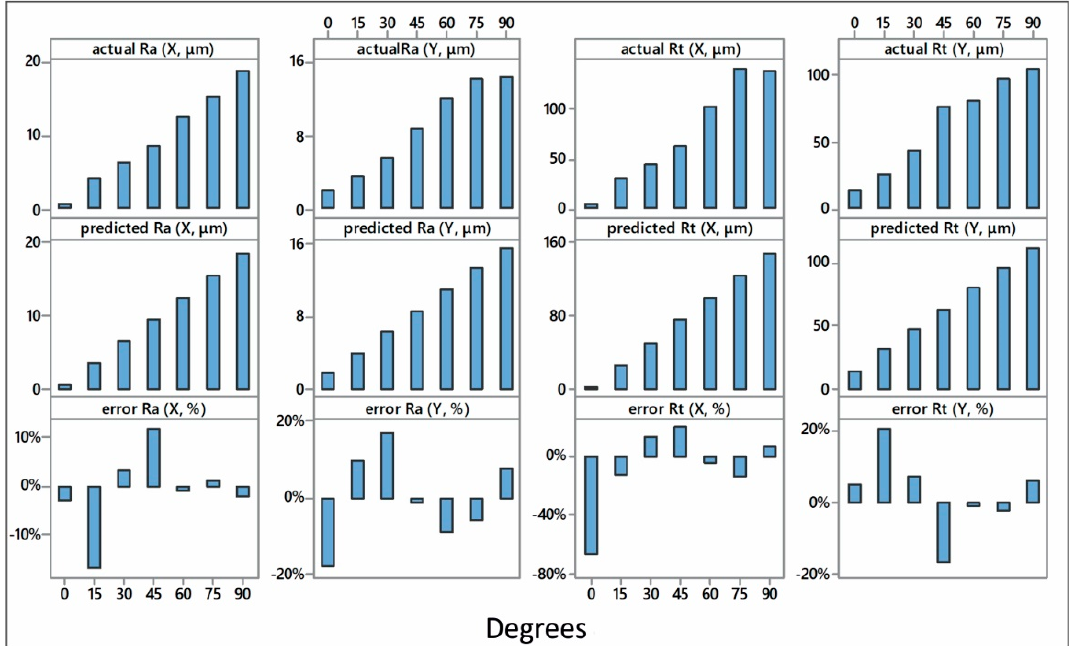
Figure 7. Bar charts for Ra and Rt values (actual, predicted and errors).